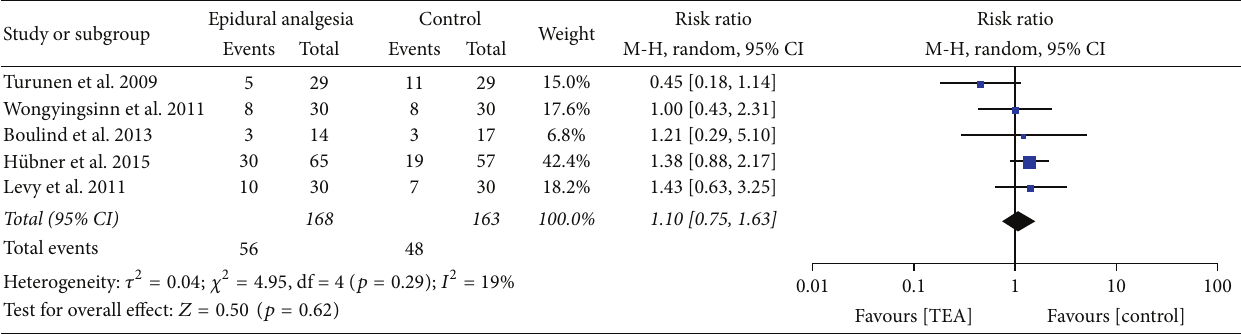
Figure 4: Postoperative complications.